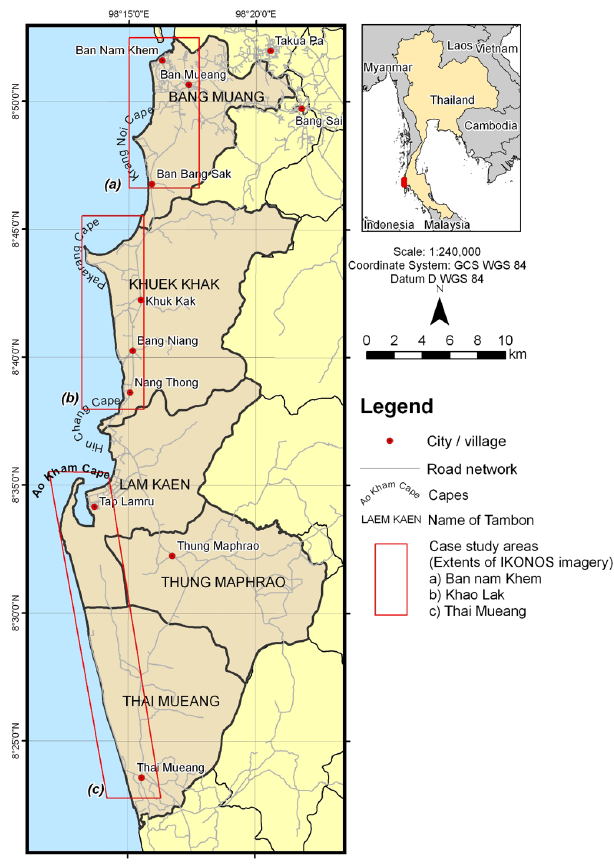
Fig. 1. The study area at the Andaman Sea coast of the Phang-Nga province,